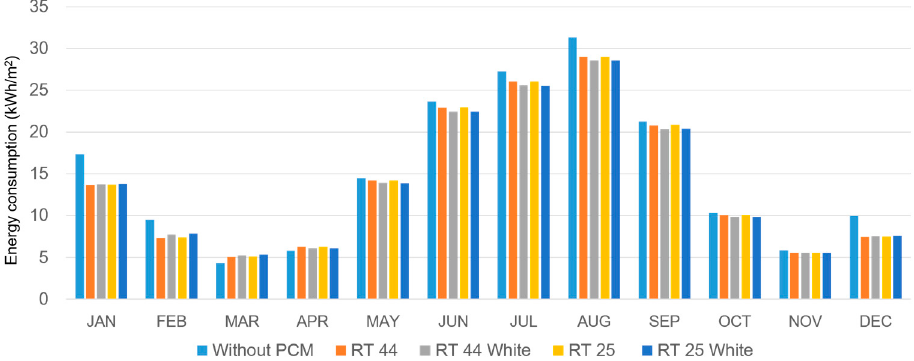
Figure 15. Monthly energy consumption by roof finishing types.